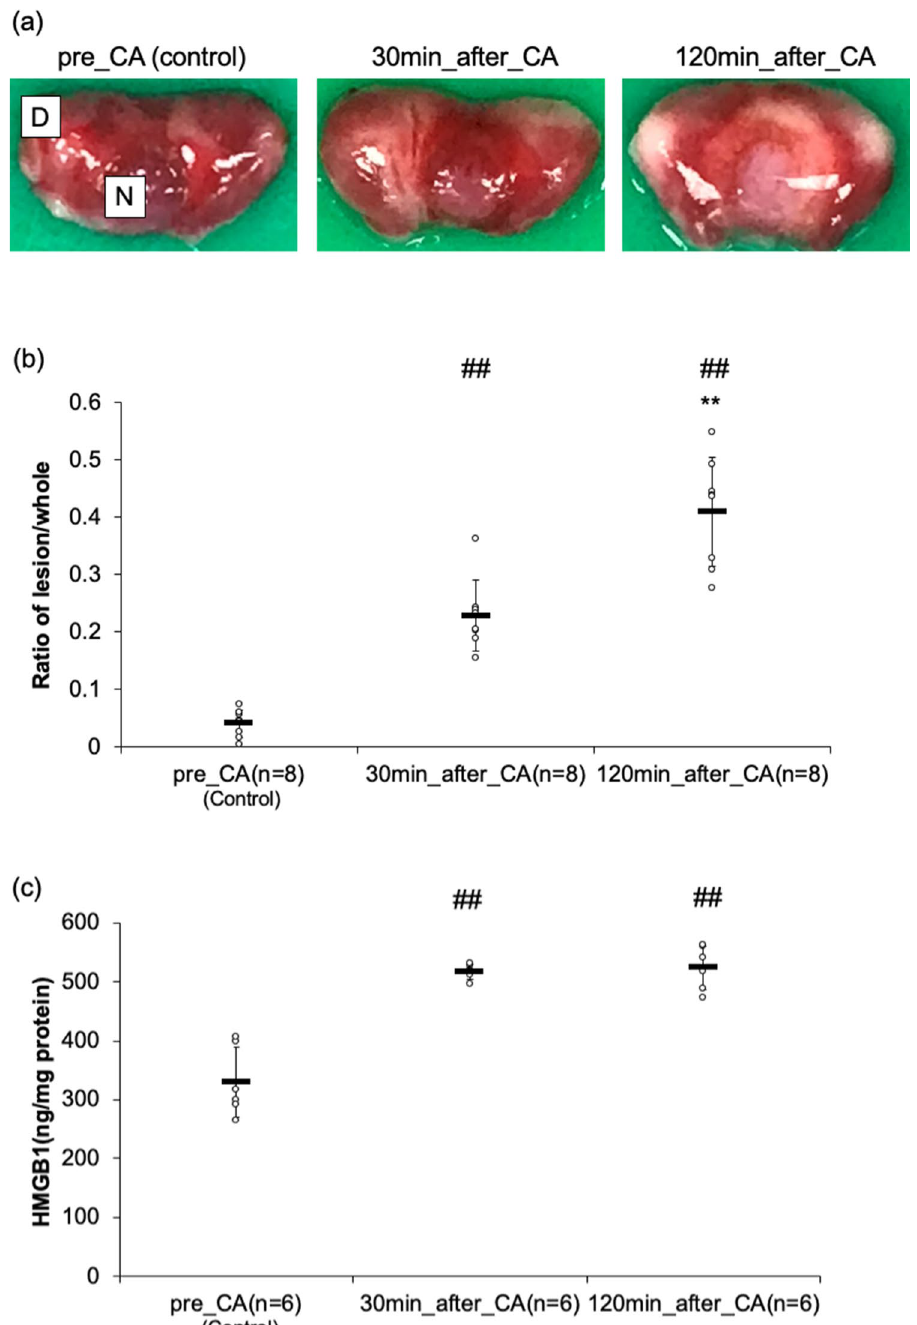
Figure 1. The evaluation of the pituitary damaged after asphyxial cardiac arrest (CA). ( a ) In order to evaluate the lesion volumes, the pituitaries were stained by 2% 2, 3, 5-triphenyltetrazolium chloride (TTC) at different time points. Every representative case from each group was shown. ( b ) We evaluated using the ratio of the lesion divided by the whole area. The results are indicated as mean ± SD. ## p < 0.01 compared with the pre-CA group. ** p < 0.01 compared with 30 min post-CA group. ( c ) In order to determine the damaged molecular patterns in the pituitary, we evaluated the pituitary HMGB-1 level by enzyme-linked immunosorbent assay in CA rats. The results are shown as mean ± SD. ## p < 0.01 compared with the pre-CA